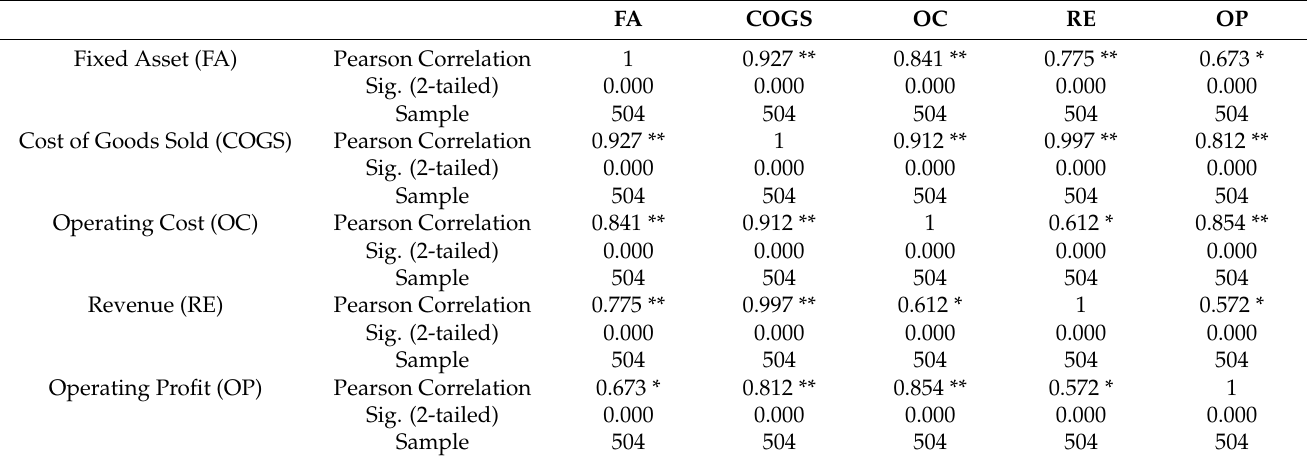
Table 6. Pearson Correlation of input and output data in